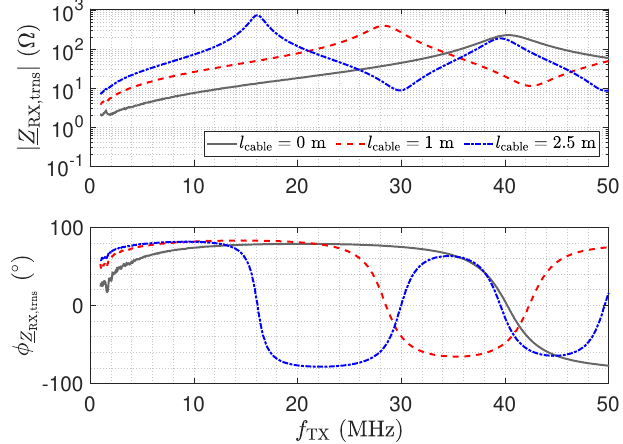
(cid:12) (cid:12) of the transformed input impedance (cid:12) Z RX,trns (cid:12) and phase φ Z RX,trns